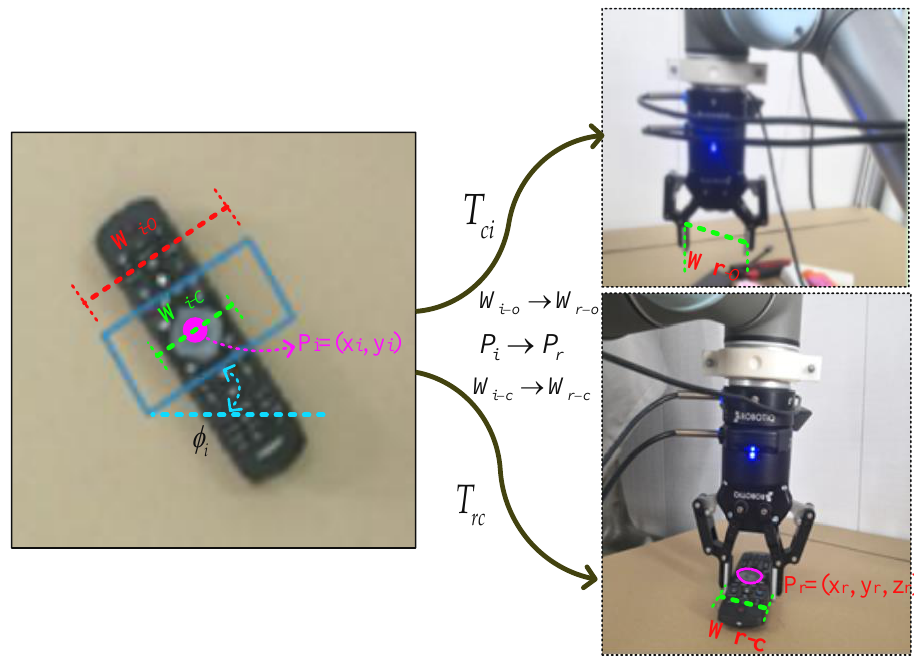
Figure 1. The representation of fine grasping in image and robotics workspace.